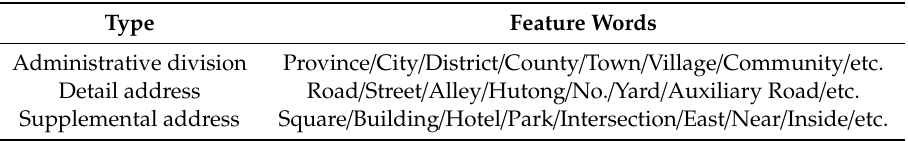
Table 1. Feature words for address element types.